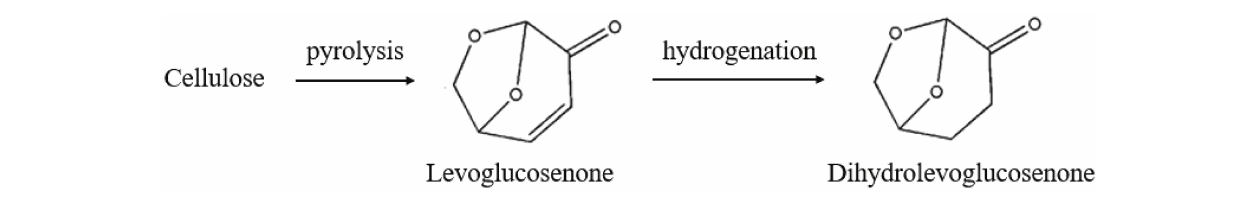
FIGURE 5 | Synthesis path of dihydrolevoglucosenone.